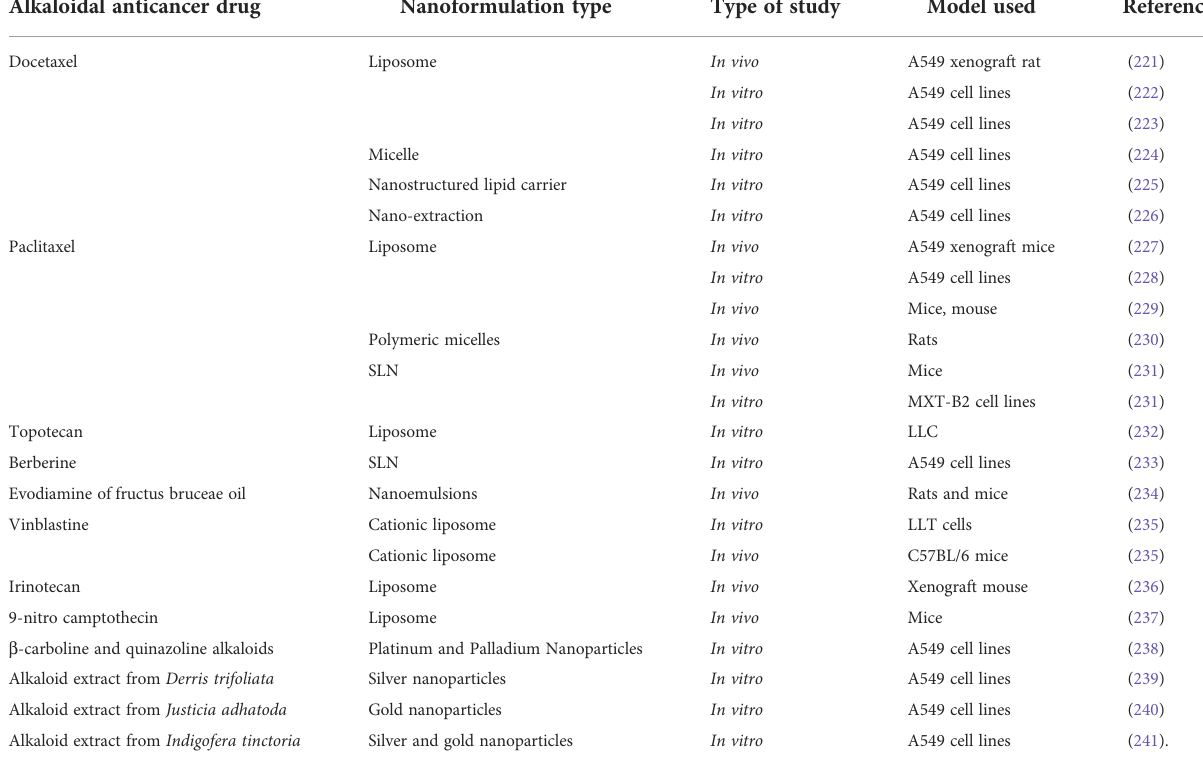
TABLE 4 Alkaloid nanoformulations for treatment of lung